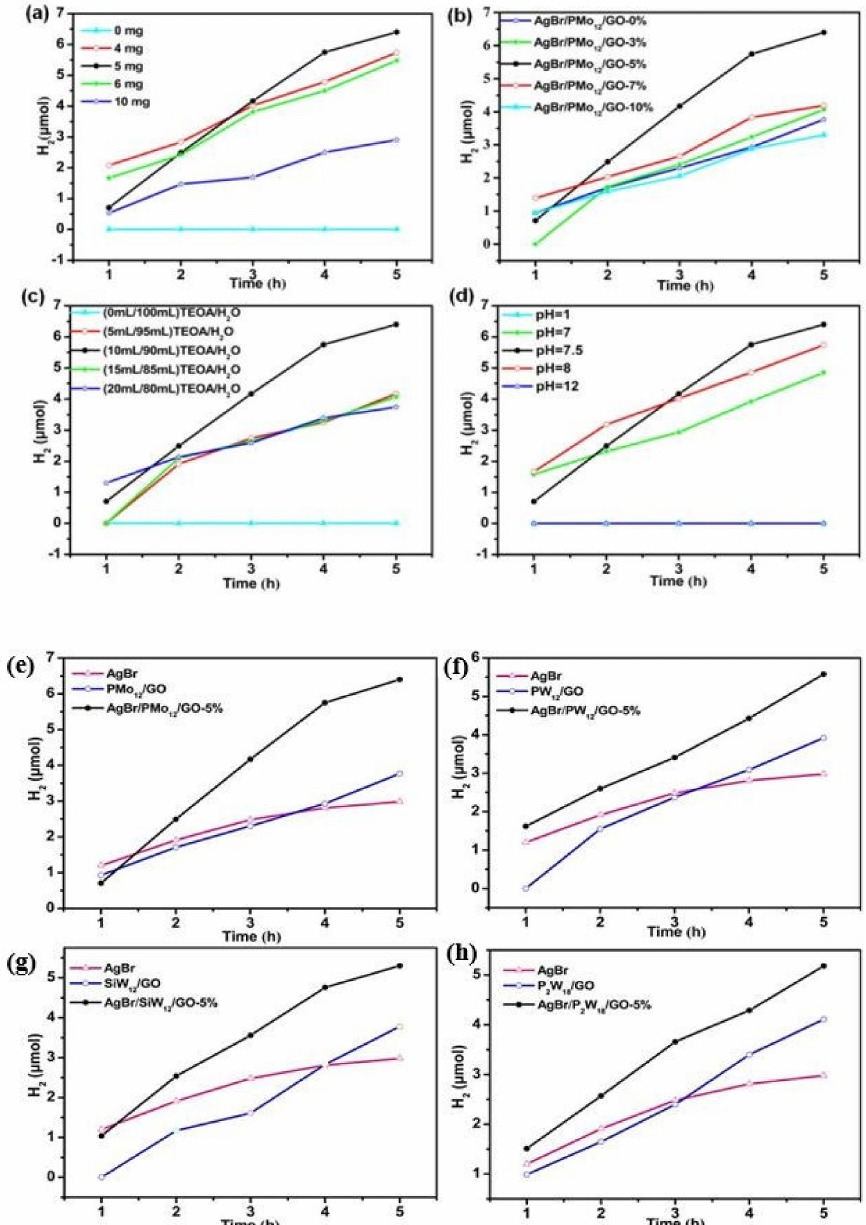
Figure 10. ( a ) Effect of the catalyst quality of AgBr/PMo 12 /GO-5% on hydrogen evolution yields. ( b ) Effect of the amount of AgBr on hydrogen evolution yields. ( c ) Effect of the content of TEOA on hydrogen evolution yields. ( d ) Effect of the pH value on hydrogen evolution yields. Photocatalytic hydrogen evolution experiments of control samples with AgBr/POM/GO-5%. Reaction conditions: 5 mg of composites ( e ) AgBr/PMo 12 /GO-5%, ( f ) AgBr/PW 12 /GO-5%, ( g ) AgBr/SiW 12 /GO-5%, and ( h ) AgBr/P 2 W 18 /GO-5% with 100 mL of 10% (V/V) TEOA/H 2 O (pH = 7.5) solution. (Reprinted with permission from reference [132]. Copyright 2021, American Chemical